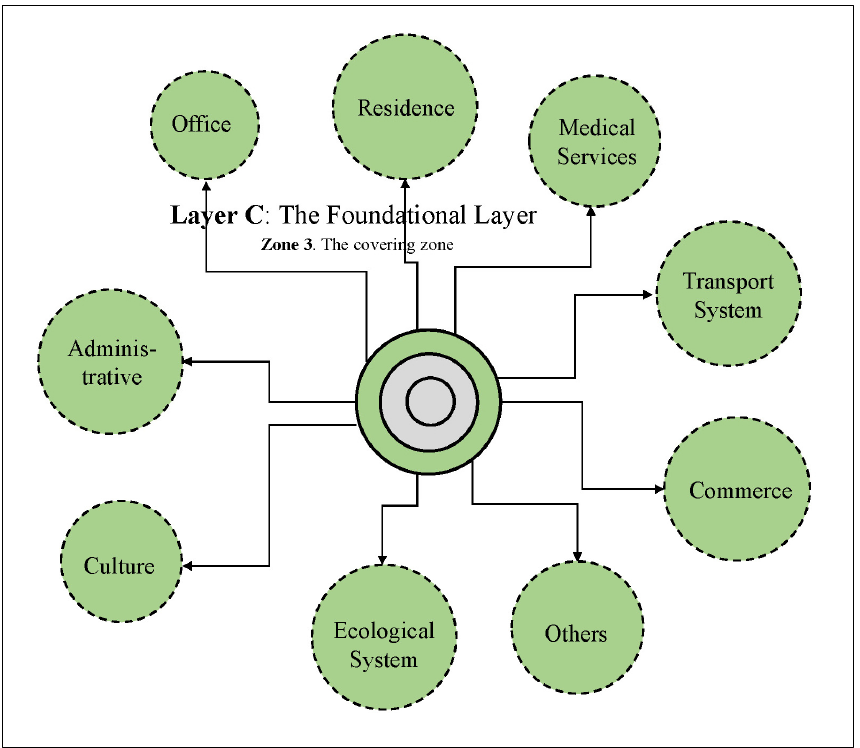
Figure 20. The main characters of Zone 3 in Layer C.